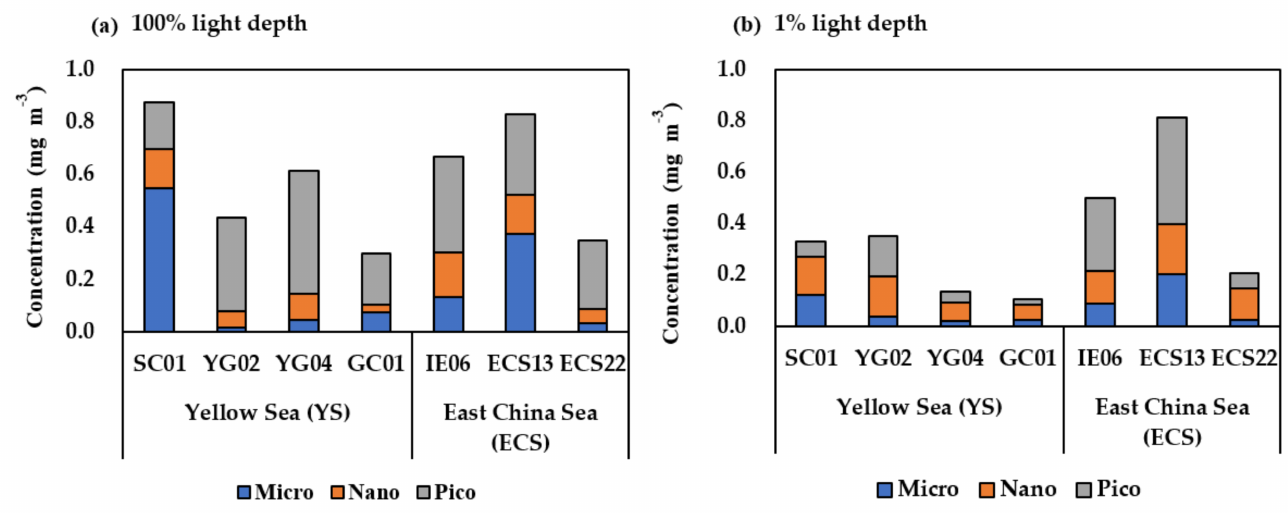
Figure 3. Total (sum of micro-, nano-, and pico-size chlorophyll- a ) and size-fractionated chlorophyll- a concentrations at ( a ) 100% and ( b ) 1% light depths in the YS and the ECS during the study